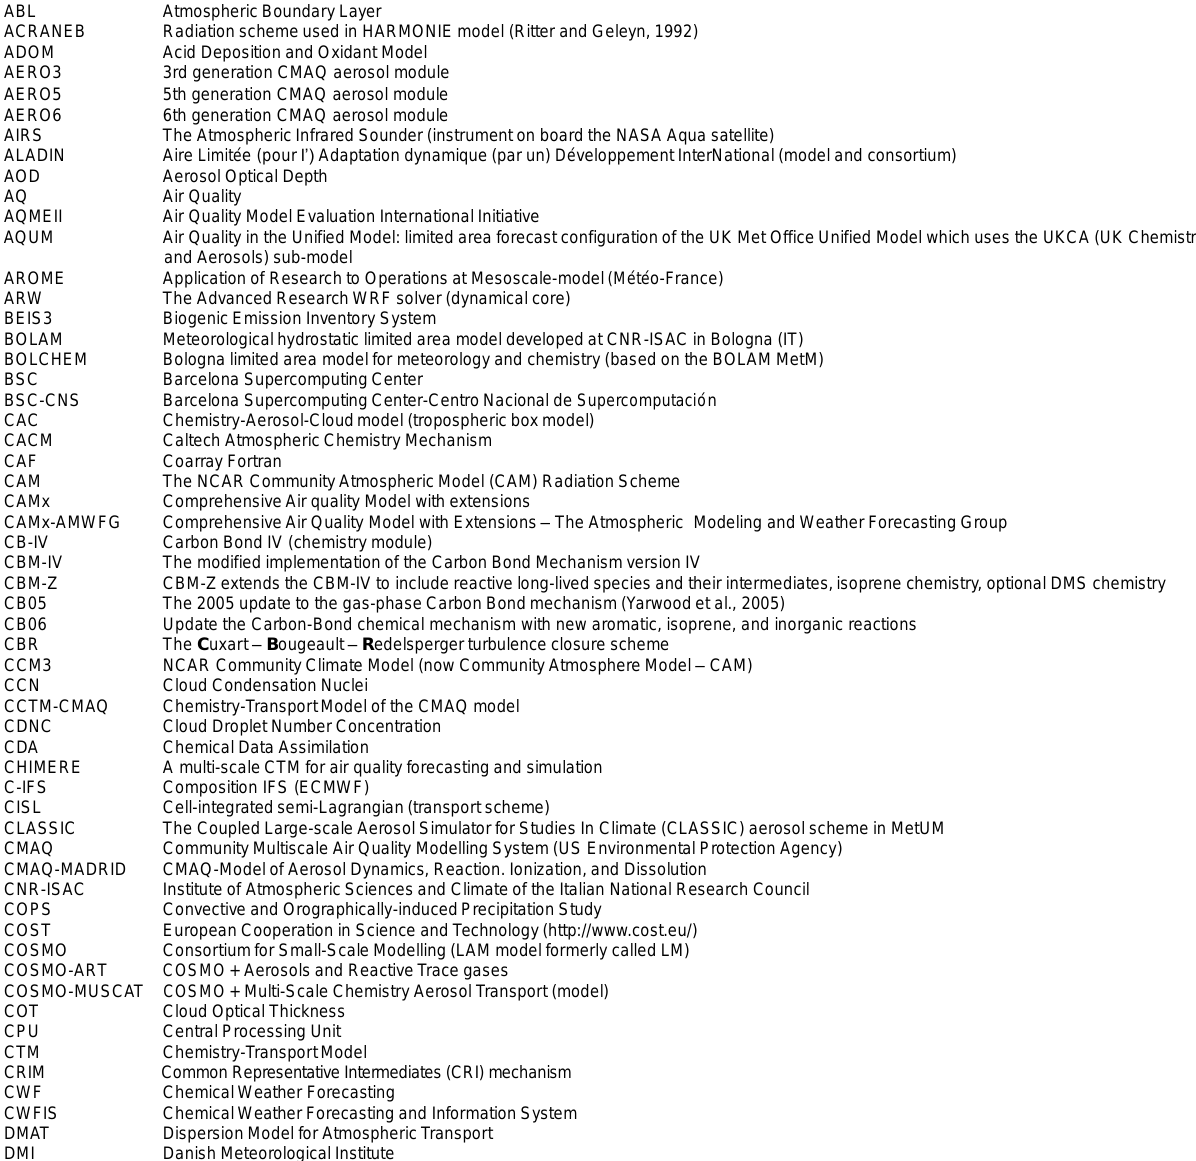
Table C1. Abbreviations and acronyms used in this article.